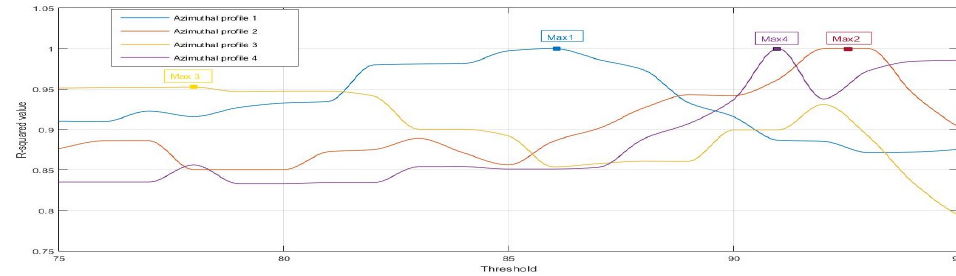
Figure 6. Plots of the R- squared metric as a function of T s for different reconstructed azimuthal